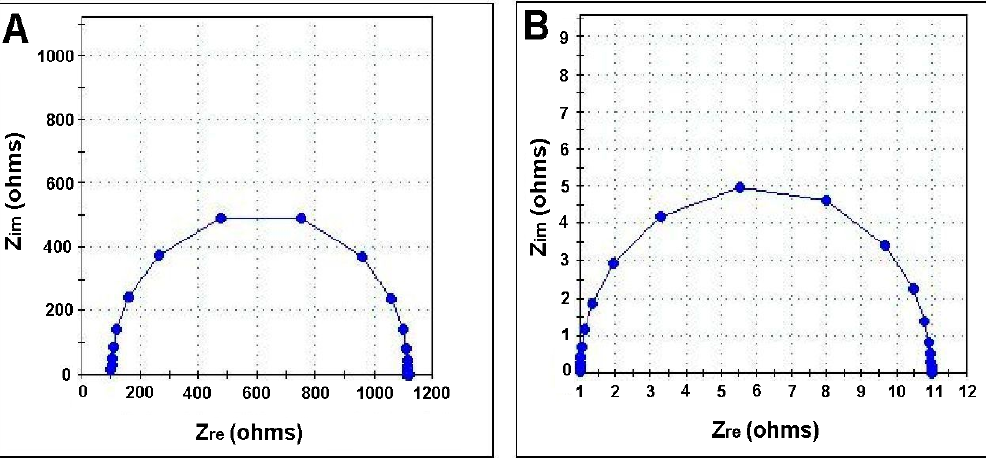
Figure 9. Nyquist diagrams for CA/PEG membrane ( A ) and CA/PEG/CHI-Ag membrane ( B ).